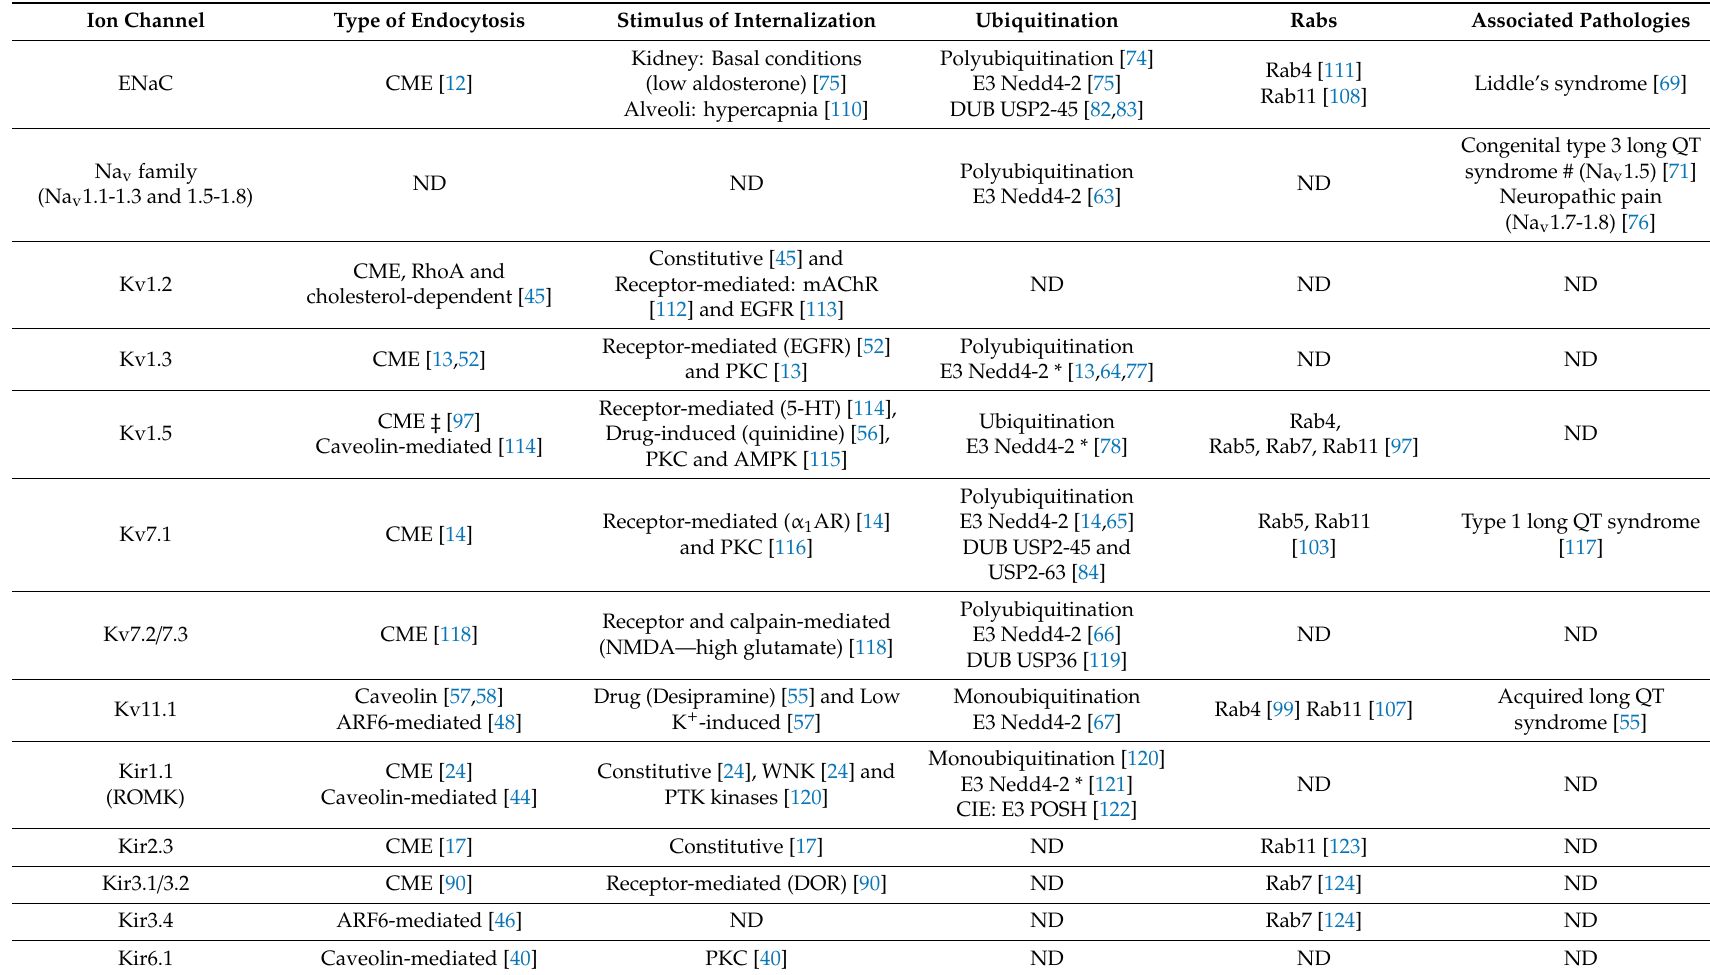
Table 1. Ion channels and their endocytic